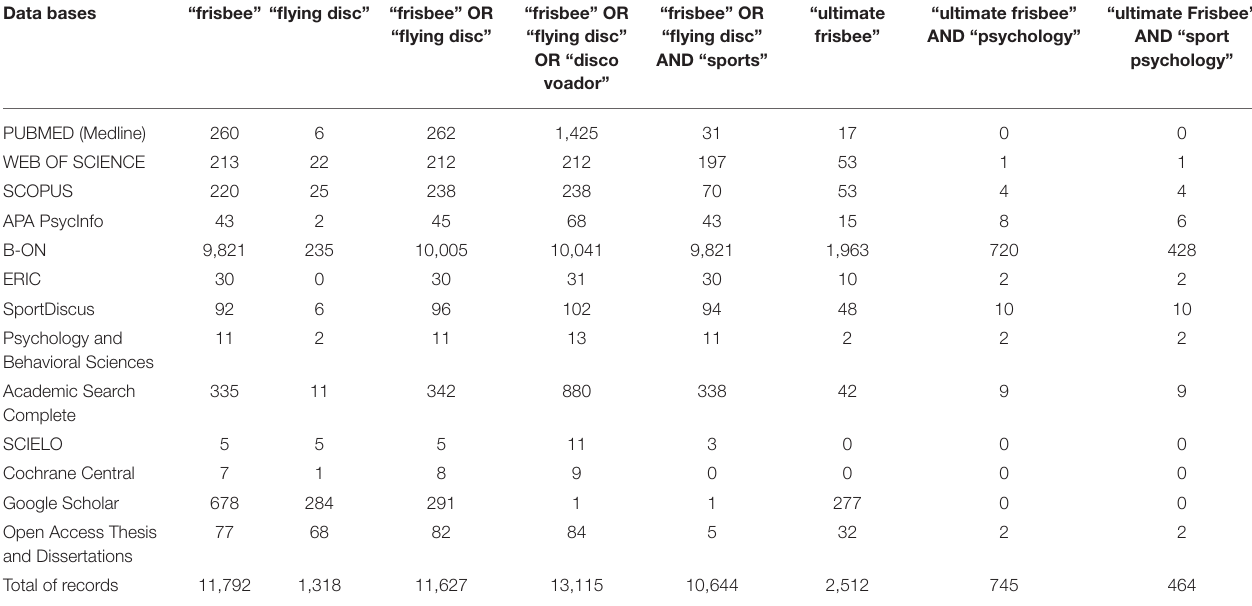
TABLE 1 | Search terms used depending on the different databases and the number of articles generated in the pilot